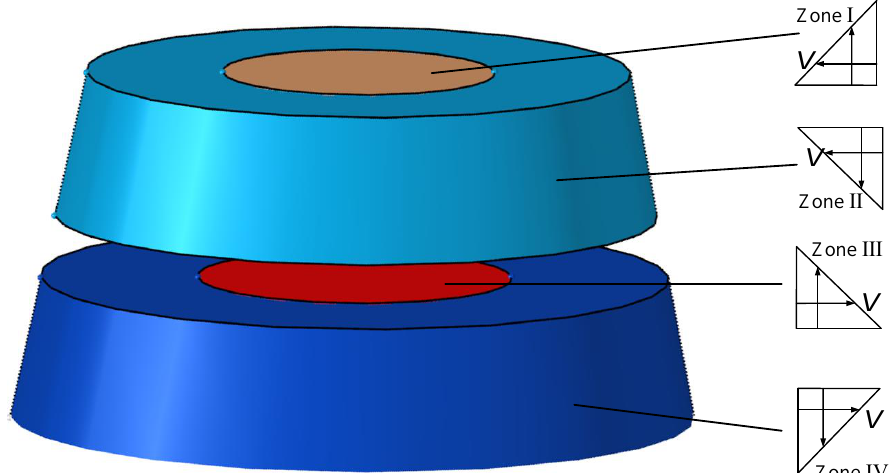
Figure 10. Division of the flow field near the wall.